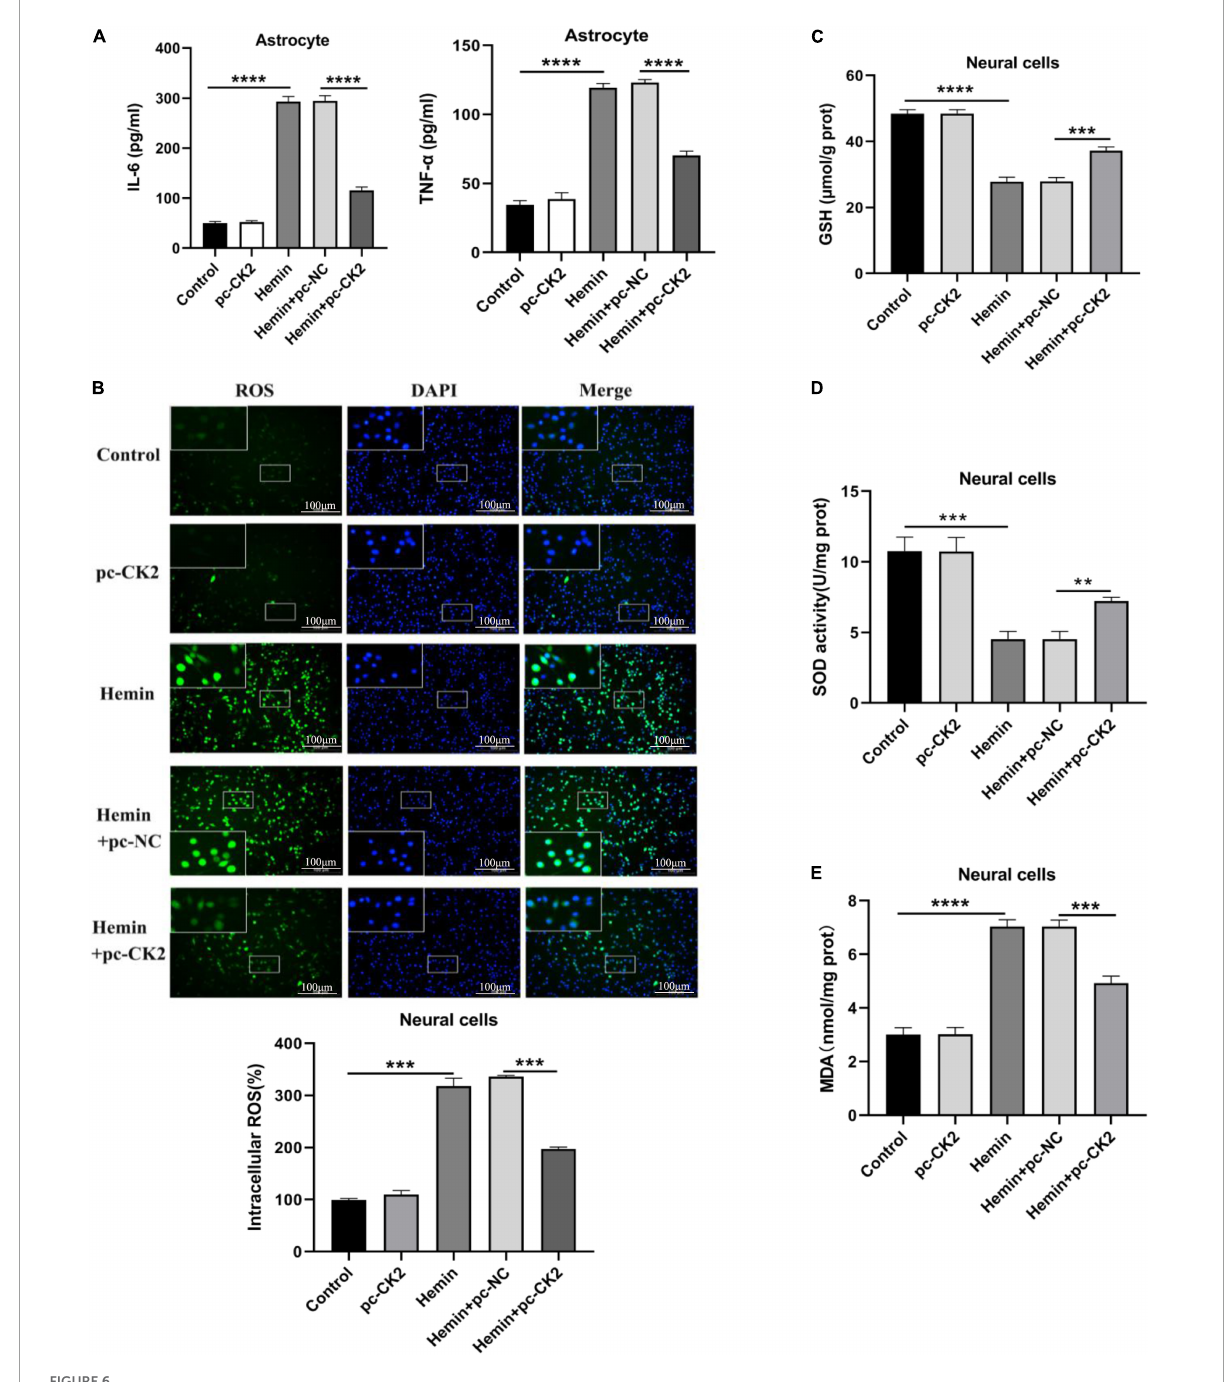
FIGURE6 Overexpression of CK2 reduced cellular inflammation and alleviated oxidative stress. pc-CK2 was transfected into Hemin-treated neurons and astrocytes. (A) Levels of TNF- α and IL-6 in astrocytes were detected using ELISA. (B) Content of ROS was determined by fluorescence probe DCFH-DA. (C–E) Contents of GSH, SOD, and MDA were detected using the kits. The cell experiment was repeated three times independently. Data were expressed as mean ± SD. ** p < 0.01, *** p < 0.001, **** p < 0.0001.